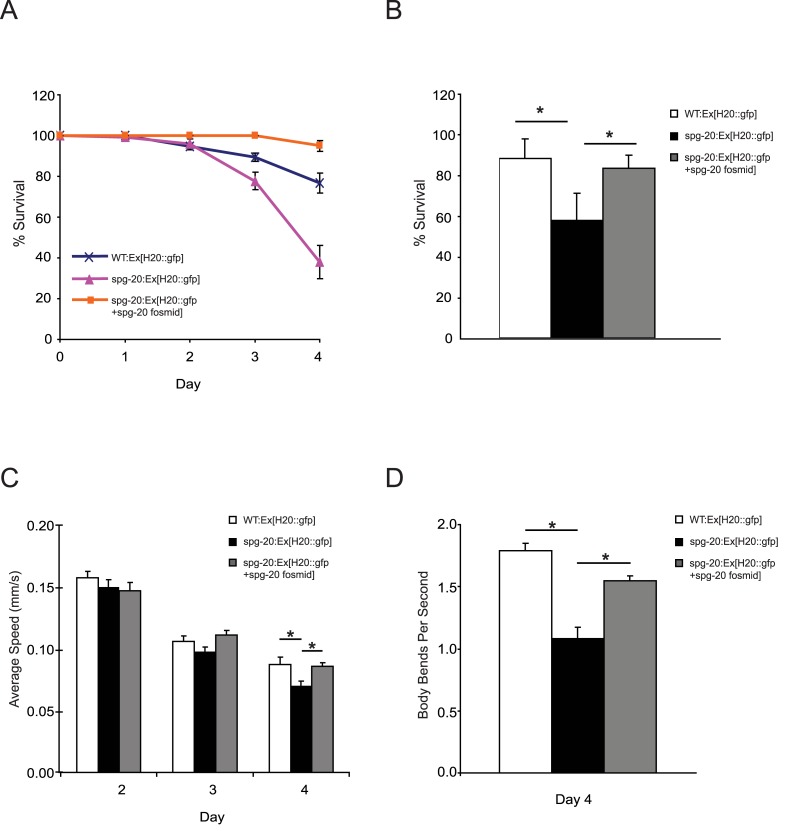

spg-20 mutant animals are sensitive to oxidative stress.
C. elegans transgenic animals expressing GFP were grown on 2 mM paraquat plates for 4 days. The L4 stage was set as Day 0. (A) Percent survival of animals after treatment with 2 mM paraquat. The percentage of animals alive was scored every 24 hours for 4 days. Animals overexpressing spg-20 had a higher survival rate than both wild-type and spg-20 mutant animals (*p<0.0001). Survival data represent at least 100 animals per genotype from four independent trials. Error bars represent SEM; Kaplan-Meier method. (B) Percent survival of animals after treatment with 100 mM sodium azide for 1 hour. The percentage of animals alive was scored after a 24 hour recovery period. Spg-20(tm5514) mutant animals had decreased survival when compared to wild type animals (*p<0.001) and animals overexpressing spartin (*p< 0.001). There was no significant difference found between the survival of wild type animals and animals overexpressing spartin. (C) Average speed of transgenic animals measured each day for 4 days after treatment with 2 mM paraquat. spg-20 mutant animals showed reduced speed, whereas animals overexpressing spg-20 showed similar speed compared with WT animals (*p<0.05). Speed was quantified by video analysis, as described in Materials and Methods. Error bars represent SEM. One-way ANOVA with Tukey test; n > 50. (D) Thrashing frequency (body bends per second) of transgenic animals in M9 liquid on Day 4 of treatment with 2 mM paraquat. Spg-20 mutant animals had a reduced thrashing rate, whereas animals overexpressing spg-20 showed a recovery in thrashing rate compared to WT animals (*p<0.01). Thrashing frequency was measured by video analysis, as described in Materials and Methods. Error bars represent SEM. One-way ANOVA with Tukey test; n > 30.